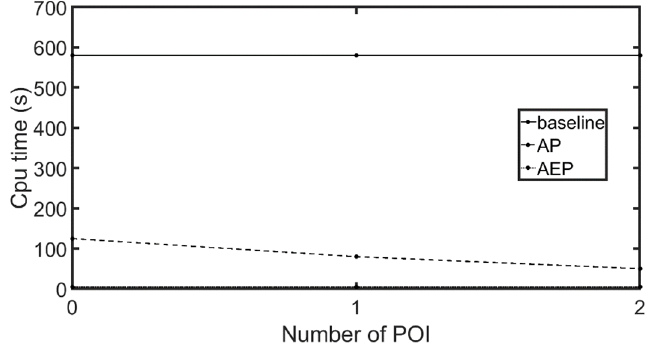
Figure 21. Computation time for queries with different poiCents.